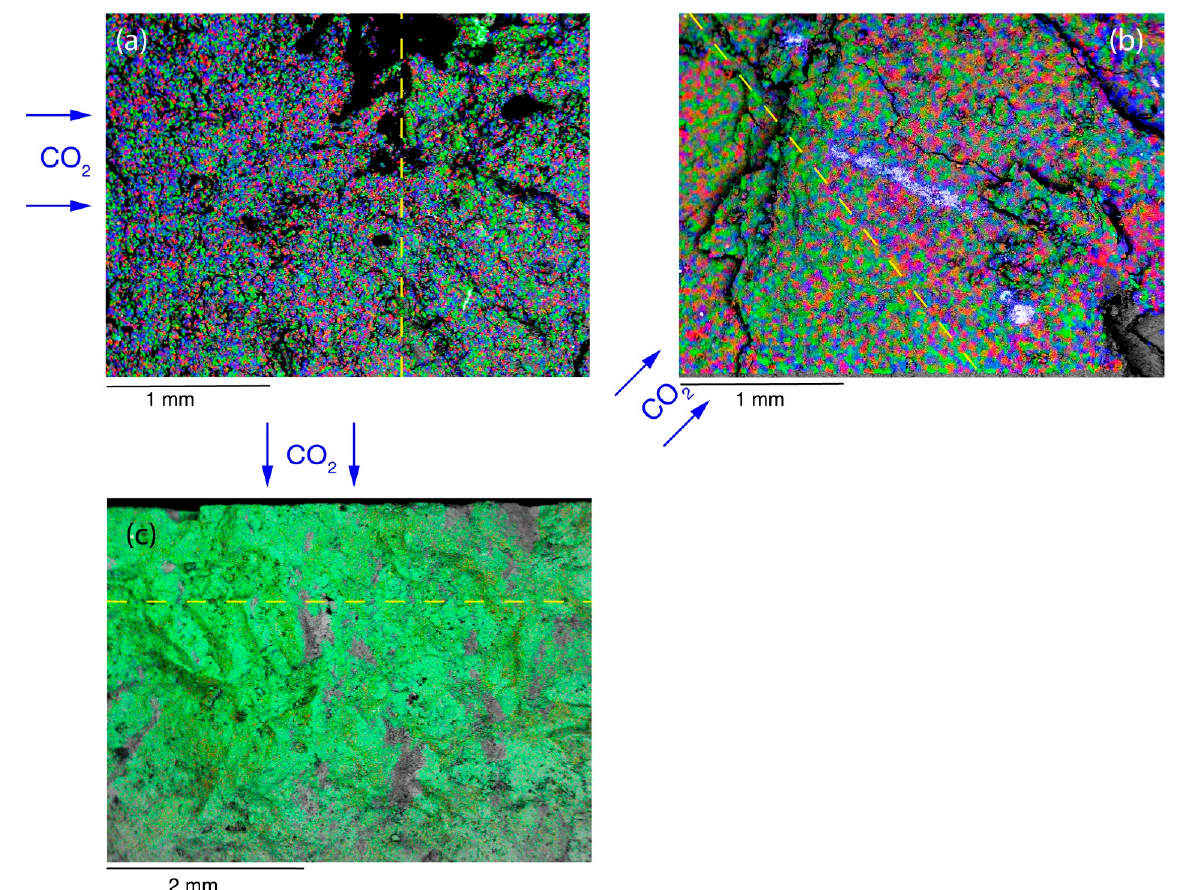
Figure 10. SEM-EDS results of C1, C2 and C3 samples. ( a ) Cameo image of C1 sample after 2 days of experiments. RGB coloring for Fe, Ca and Mg, respectively. ( b ) Cameo image of C2 sample after 5 days of experiments. RGB coloring for K, Mg and Fe, respectively. ( c ) Cameo image of C3 sample after 5 days of experiments. Fe abundance in green color. Colors distribution highlight the reaction front (yellow line). Images taken from a piece on a stub.